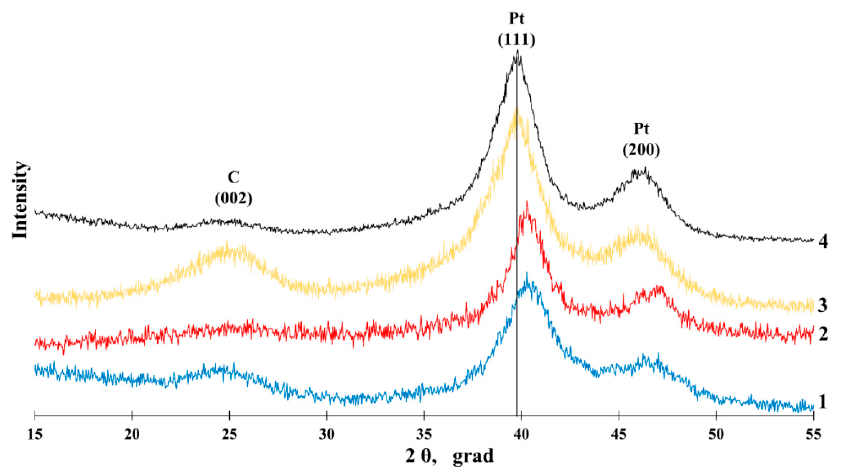
Figure 2. XRD patterns of PtCo/C materials: 1—PCC1; 2—PCC2; 3—commercial Pt/C sample (JM20); 4—commercial Pt/C sample (JM40).